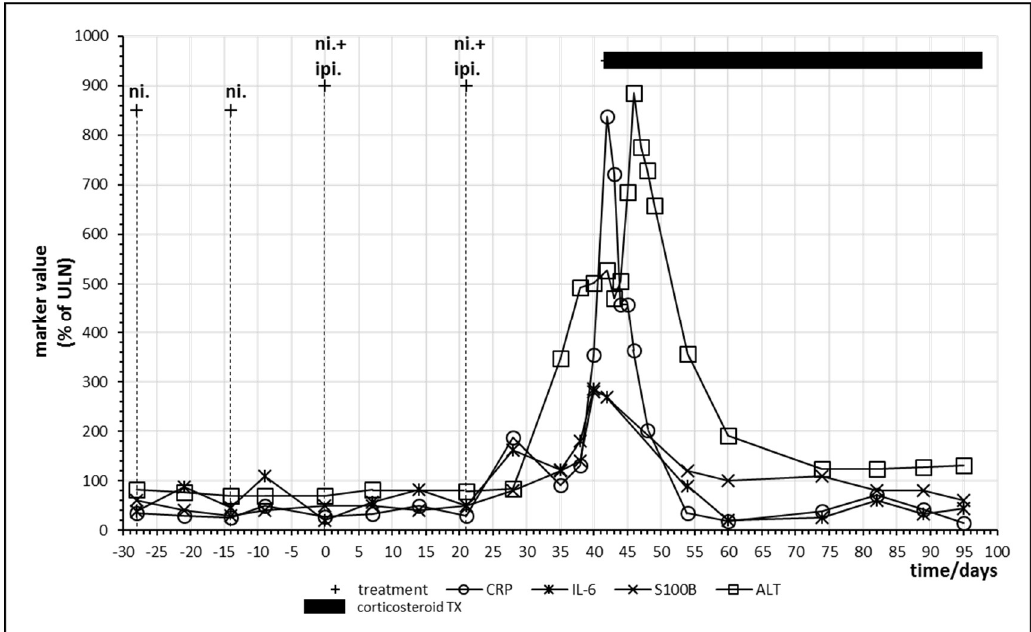
Figure 6. Time course of immune, tumor and cell damage (ALT) markers during checkpoint inhibitor treatment. Patient no. 8, last two cycles of nivolumab; two cycles of nivolumab plus ipilimumab starting at day 0.